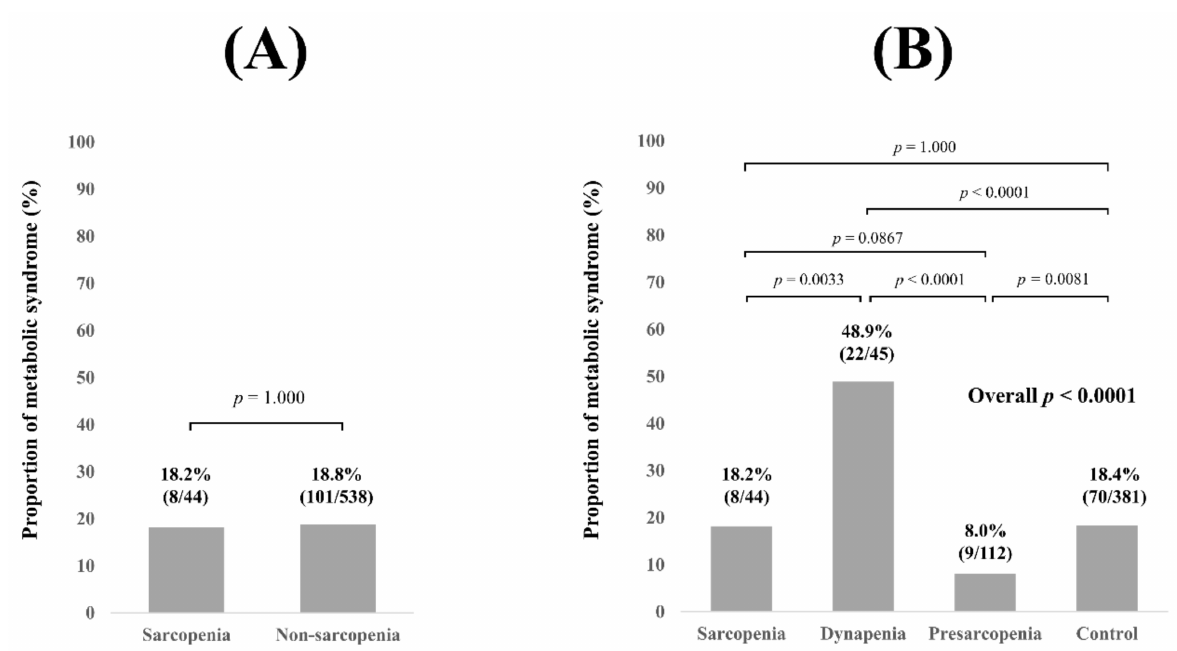
Figure 2. ( A ) Proportion of Met-S in patients with sarcopenia and non-sarcopenia for all cases (n = 582). ( B ) Proportion of Met-S in patients with sarcopenia, dynapenia, presarcopenia, and control for all